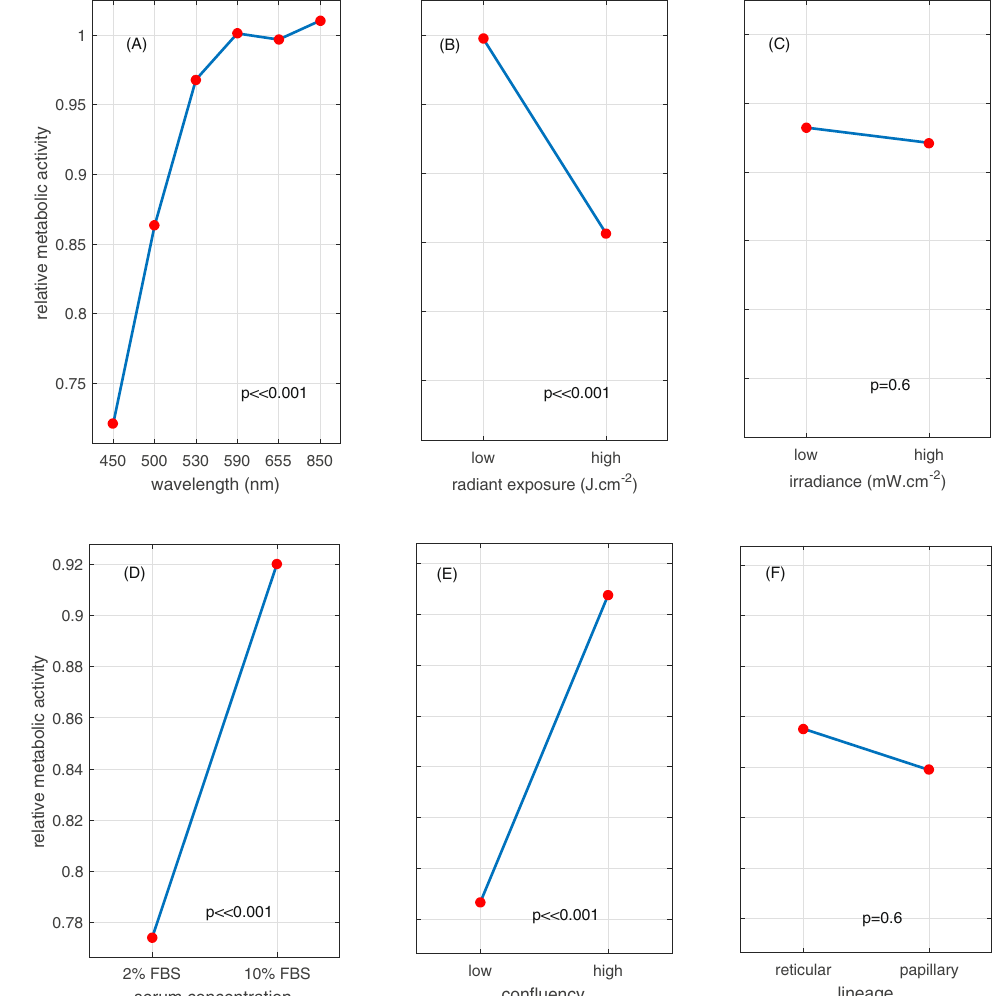
Figure 1. Main effects plot of the wavelength, radiant exposure, irradiance, serum concentration, initial cell confluency and lineage on the relative metabolic activity of fibroblasts. Main effects plot of the wavelength ( A ), radiant exposure ( B ) and irradiance ( C ) on the relative metabolic activity of human dermal fibroblasts (reticular and papillary). Data points correspond to grand means, i.e. the average value of the metabolic activity for each level of one selected factor (wavelength, dose or irradiance) while all the levels of the two other factors are averaged. Statistical significance was evaluated using ANOVA (N = 3, 2 lineages and 3 replicates). The levels of radiant exposure correspond to 2 J.cm − 2 (low) and 30 J.cm − 2 (high), the levels of irradiance depended on wavelength and are reported in Table 1 in the Materials and Methods Section. Main effects plot of serum concentration ( D ), initial confluency ( E ) and lineage ( F ) on the relative response of the metabolic activity of human dermal fibroblasts after light treatment (450 nm, 2 to 60 J.cm − 2 ). Data points correspond to grand means, i.e. the average value of the metabolic activity for each level of one selected factor (serum concentration, confluency, lineage) while all the levels of the two other factors are averaged. Statistical significance was evaluated using ANOVA (N = 2, 2 lineages and 3 replicates). The initial ratio at the moment of seeding between ‘high’ and ‘low’ confluency groups is 5. The control group is has an average relative metabolic activity of